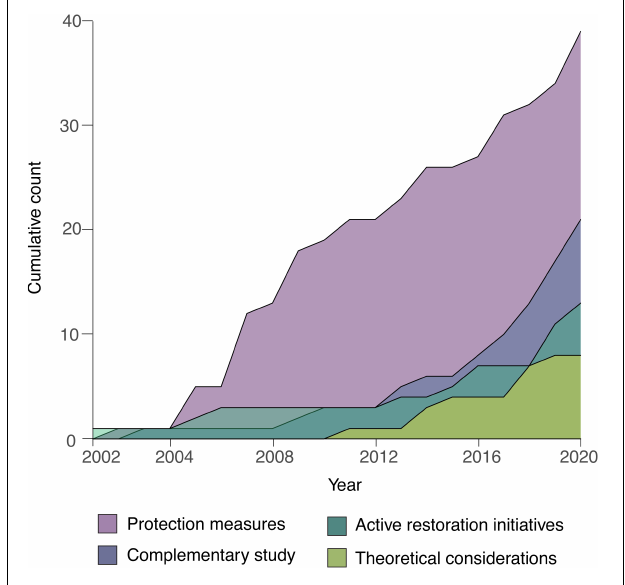
FIGURE 1 | Cumulative count of scientific publications related to CWC restoration over time and according to the study type ( N =